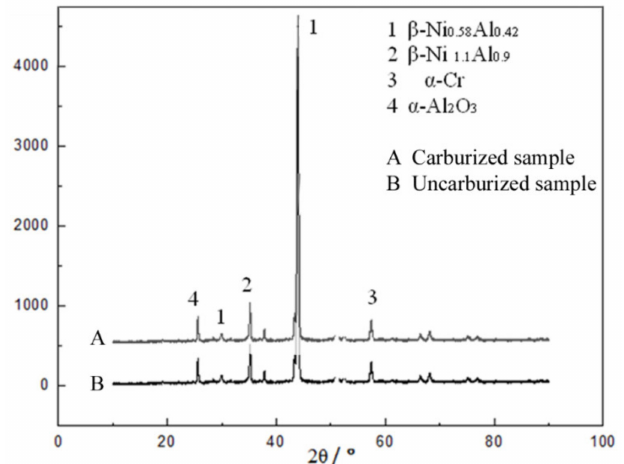
Figure 3. XRD patterns of the carburized and uncarburized DD10 superalloys with an HY5 coating after thermal cyclic oxidation at 1100 °C for 300 h.